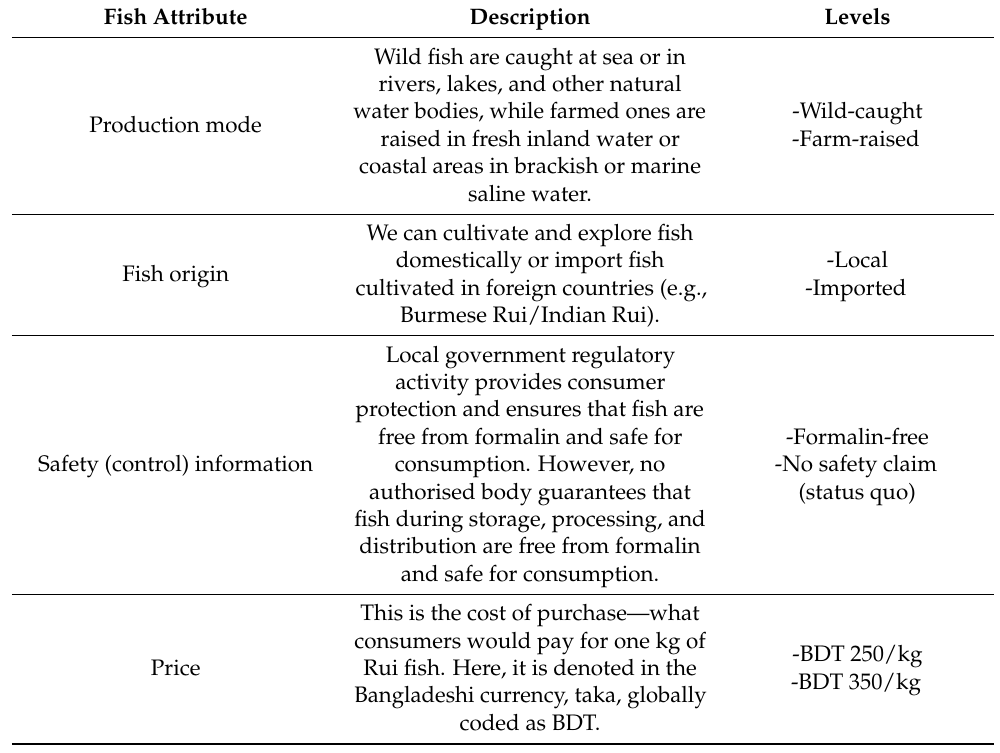
Table 1. Fish attributes and levels for the choice experiments.